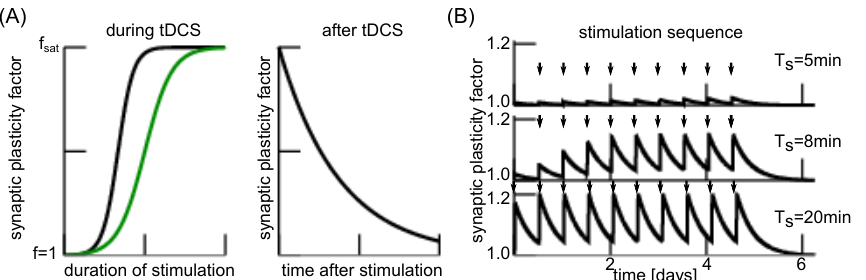
Figure 3. Modelled plasticity impact during and after anodal tDCS stimulation. ( A ) Left panel: very short stimulus duration does not induce any plasticity (the synaptic plasticity factor is f ≈ 1), medium duration exhibits a strong plasticity effect (1 ≤ f ≤ f sat ) that is not enhanced anymore for long-duration stimuli [6] ( f → f sat ) with saturation factor f sat . For high and low a-tDCS currents (black and green curve, respectively), the qualitative behaviour is similar, but it takes more time to induce the same plasticity effect for lower a-tDCS currents [71]. Our model describes this temporal evolution of plasticity effect by a population growth model, see Appendix A.2 for more details. Right panel: after stimulation offset the plasticity effect diminishes exponentially with time. Experimental studies [71] indicate that the decay time scale is in the range of tens of minutes for typical previous stimulation current ( ∼ 0.5–1 mA). ( B ) Simulation of the plasticity effect in a typical a-tDCS sequence motivated by [6]. Arrows indicate stimulation periods. A single a-tDCS period had a duration T s with a stimulation pause of 12 h, 10 repetitions and a final period of 34 h, cf. Appendix A.2 for more details. Further parameters are τ plast = 3 h and τ decay = 500 h.